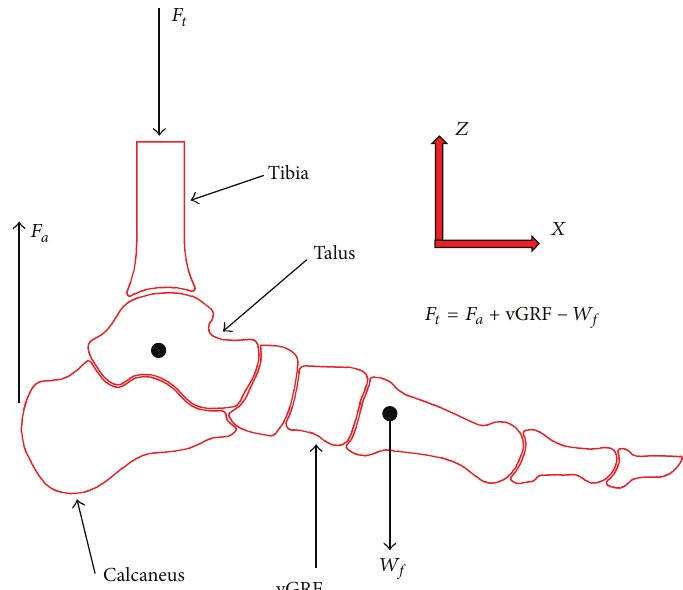
Figure 4: Force analysis of the foot and ankle used to set the parameters of loading, where 𝐹 𝑡 represented the axial tibia load, 𝐹 𝑎 was the AT load, vGRF was the vertical ground reaction force, and 𝑊 𝑓 was the weight of the foot and tibia.